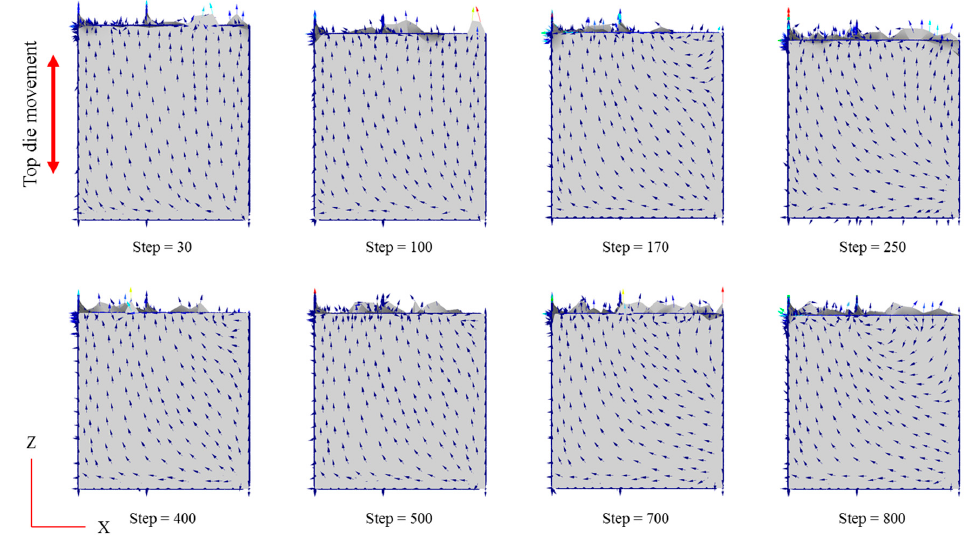
Figure 11. Vector distribution on the workpiece throughout the hot press forging simulation.